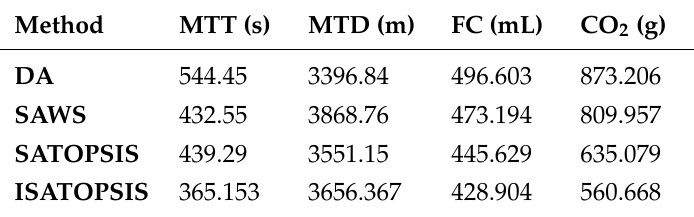
Table 3. The average results obtained by the Dijkstra algorithm (DA), simulated annealing weighted sum (SAWS), the simulated annealing technique for order preference by similarity to the ideal solution (SATOPSIS) and the improved simulated annealing technique for order preference by similarity to the ideal solution (ISATOPSIS) in the tested scenarios. MTT, mean travel time; MTD, mean travel distance; FC, fuel